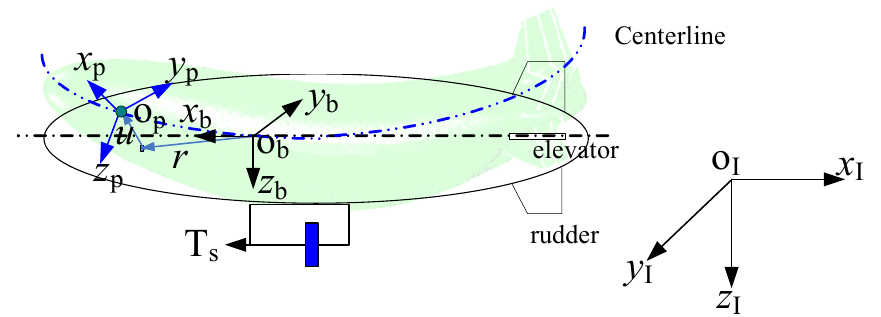
Figure 1. Structure of the flexible airship and the reference frames.